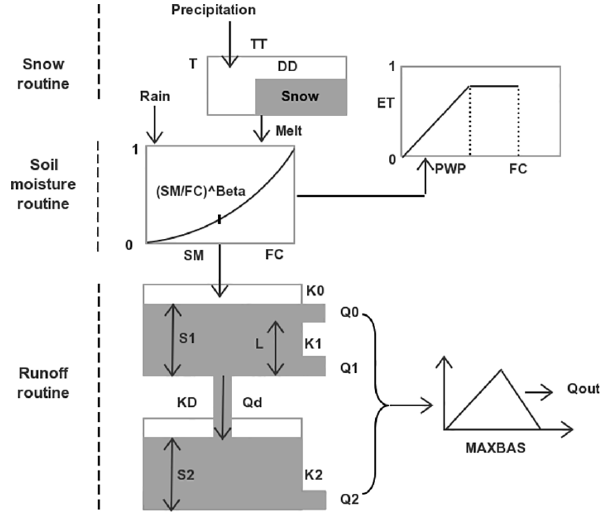
Figure 4. Schematic representation of the HBV